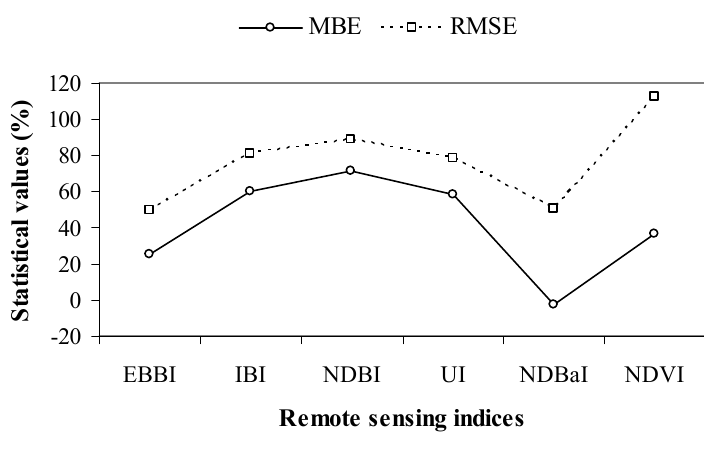
Figure 5. Mean bias error (MBE) and root mean square error (RMSE) statistical values between the percentage of built-up area and the remote sensing transformation